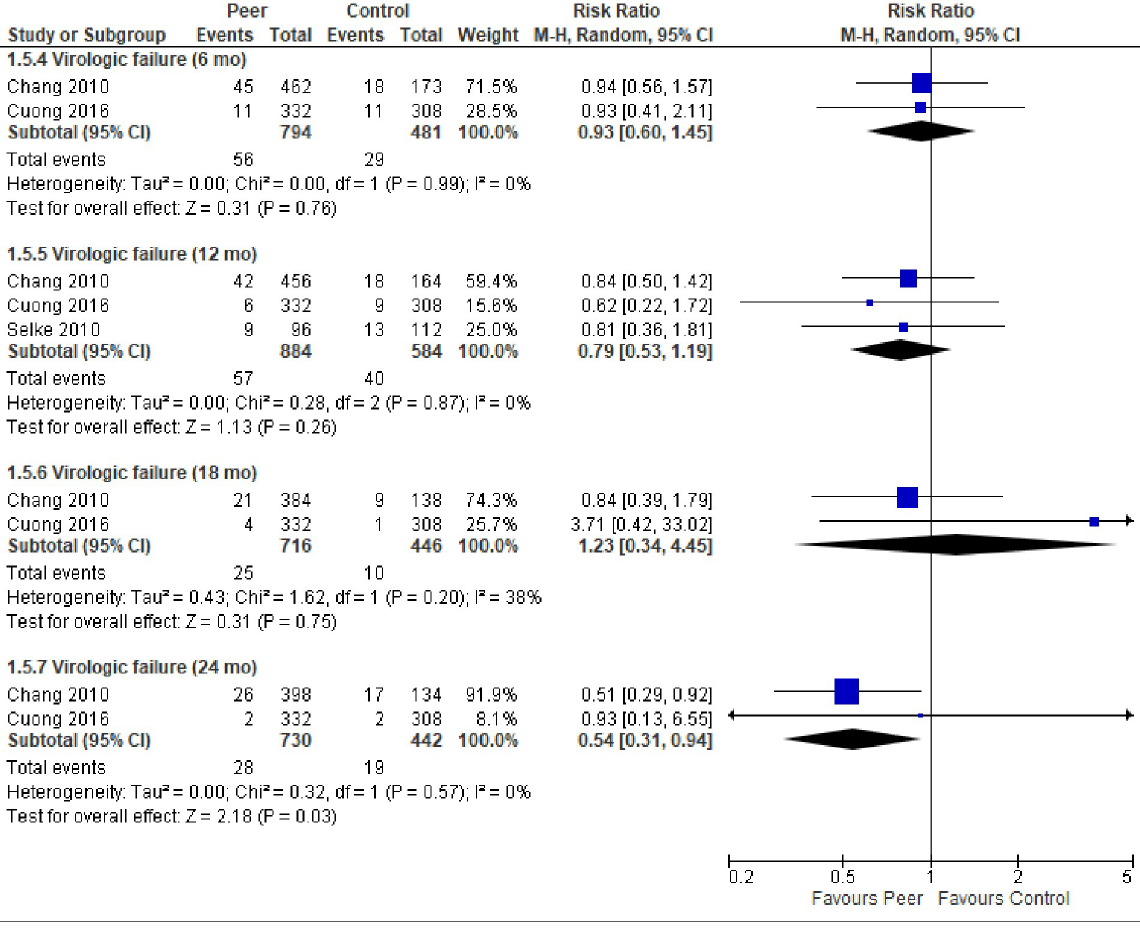
Fig 7. Meta-analyses of outcome virologic failure.